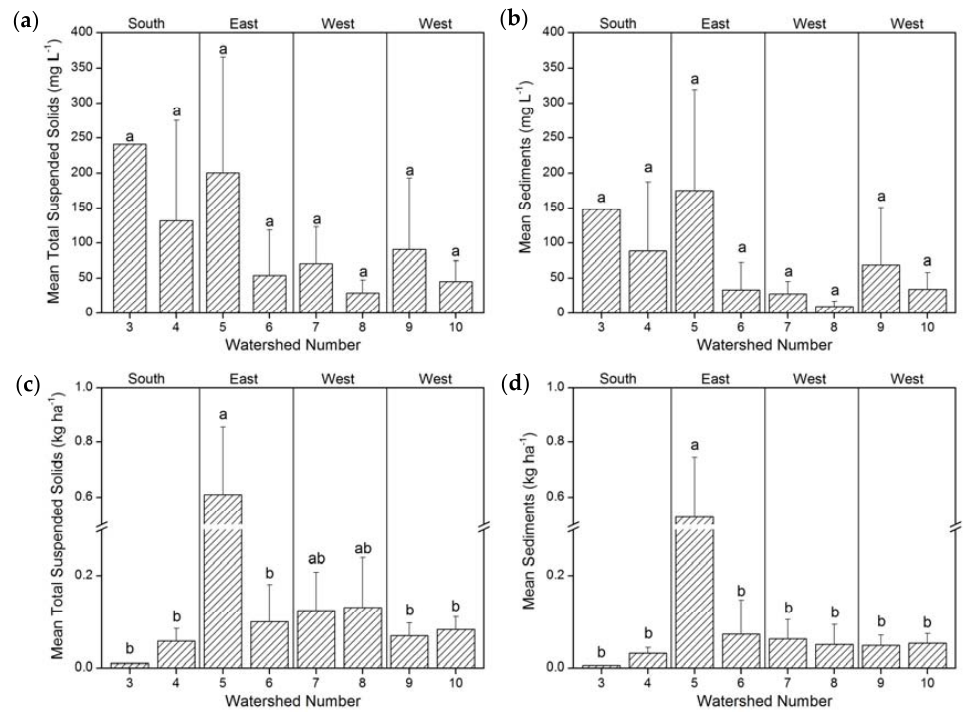
Figure 6. Comparisons of mean ±95% confidence interval (CI) for pre ‐ burn ( a ) total suspended solids concentration; ( b ) sediments concentration; ( c ) total suspended solids loads; and ( d ) sediment loads by paired ‐ watersheds. Significant differences ( p values < 0.05) are noted by different letters at the top of each bar.